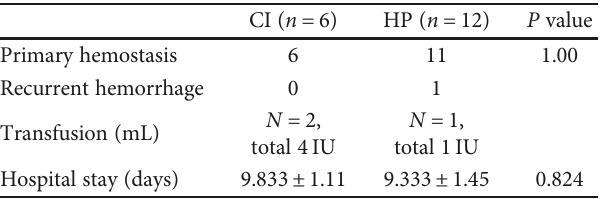
Figure 2: A male (28 years old) duodenal DL patient received hemoclip placement during upper endoscopy. (a) A protruding vessel 1 month post endoscopy, without active hemorrhage on the superior part of the duodenum. (b) Hemoclip placement. (c) 10 days after endotherapy. Table 2: Clinical outcomes of cyanoacrylate injection and hemoclip placement on Dieulafoy ’ s